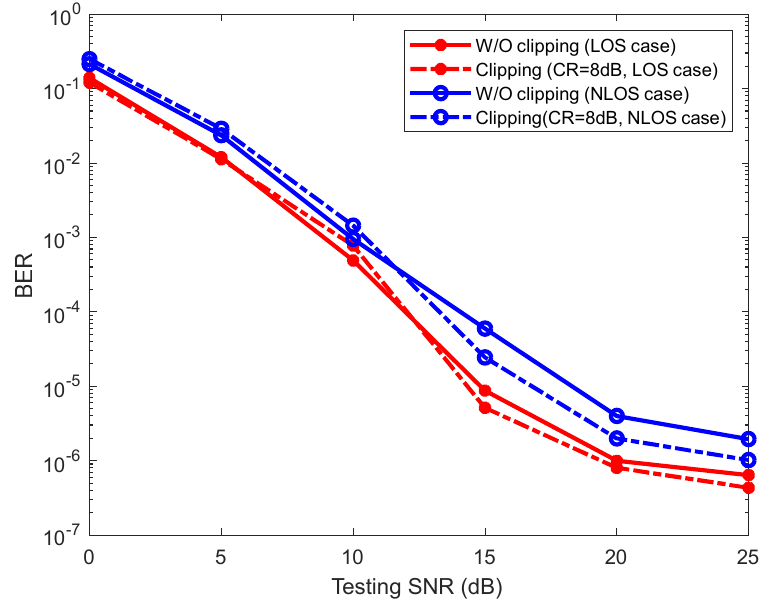
Figure 10. BER performance of the proposed scheme under clipping conditions.